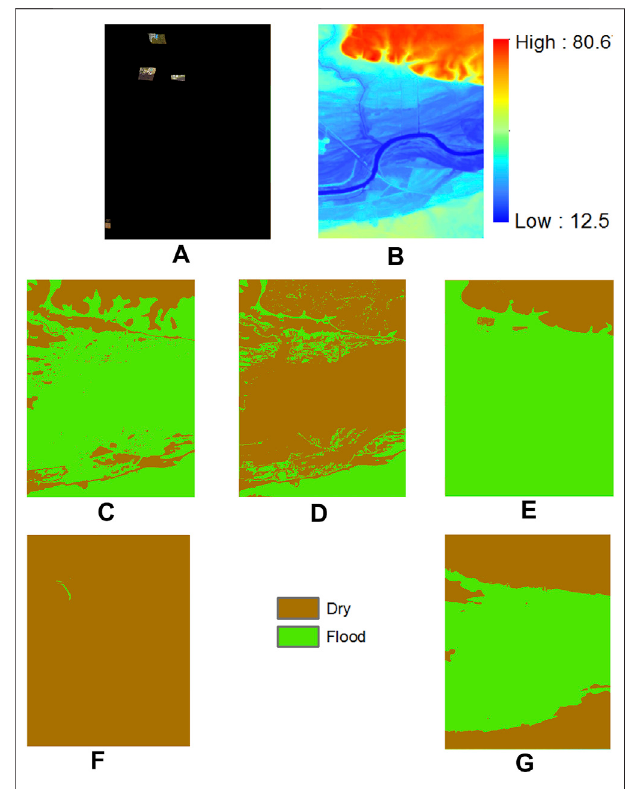
FIGURE 7 | Results on Matthew fl ood, Kinston, NC (A) Limited observation aerial imagery in Kinston NC (B) Digital elevation model (C)